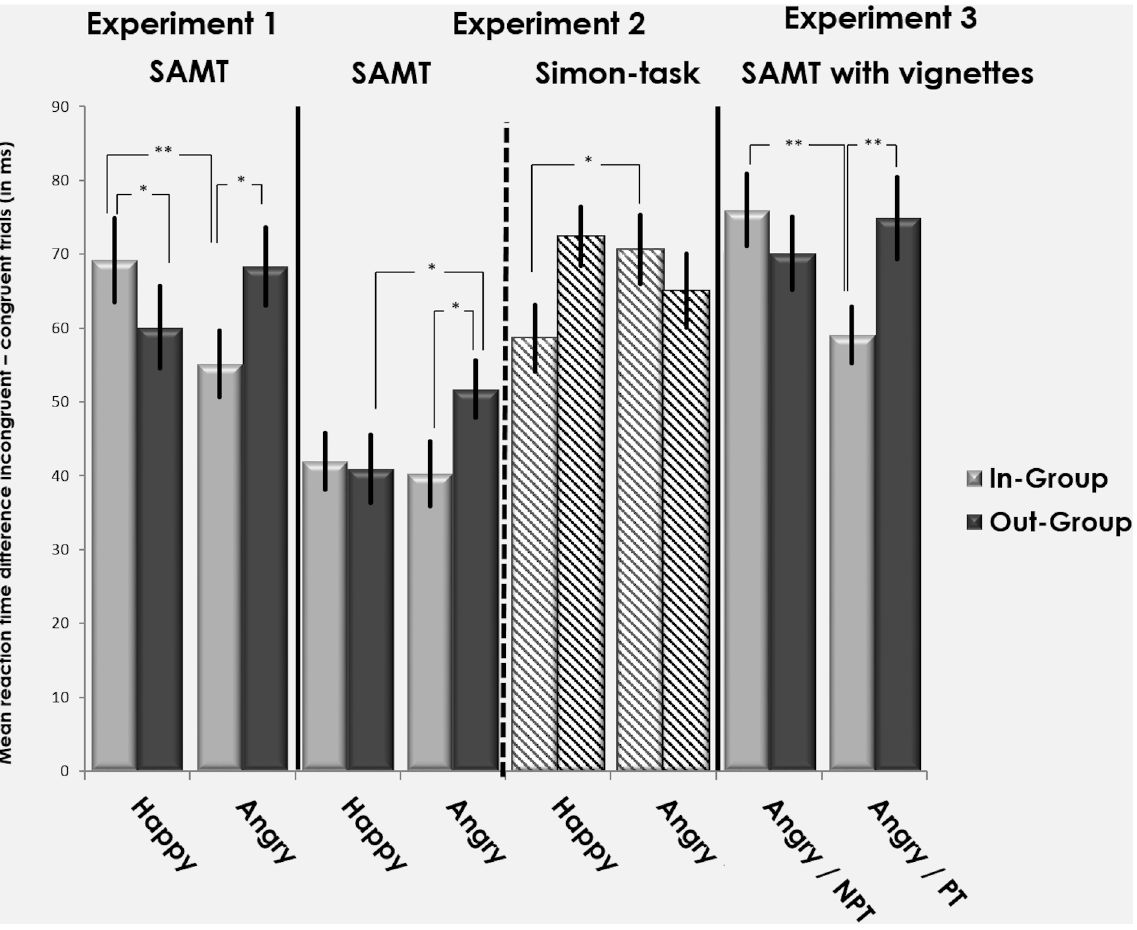
Fig 2. Social-affective mimicry task (SAMT, Experiment 1 and 2), Simon-task (Experiment 2) and SAMT with vignettes (Experiment 3). Bars represent the mean reaction time (RT) differences on incongruent and congruent trials of the social-affective mimcry task (Experiment 1 and 2) and Simon Task (Experiment 2); RT units are in ms; error bars represent standard error of the mean (SE) ; * p (cid:1) .05, ** p (cid:1) .01, NPT = No Personal Threat, PT = Personal Threat.